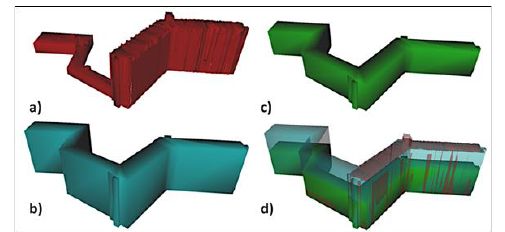
Figure 3. Example of the same building modelled according to: (a) the LoD2 model provided by the Municipality of Amsterdam, (b) the LoD1 model from the 3D BAG dataset, (c) the volumetric model obtained from the nDSM, and (d) a comparison of the 3 models to show the differences in terms of enclosed volumes. Image taken from Agugiaro et al. (2020).